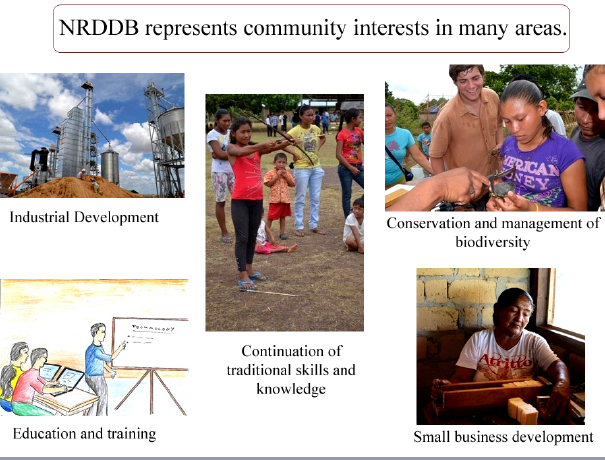
Fig. 8 . The role of the North Rupununi District Development Board (NRDDB) in the coexistence best practice